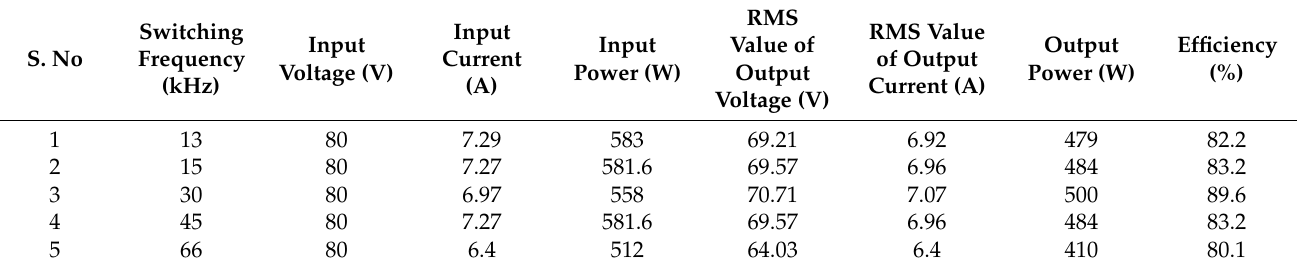
Figure 8. Variable frequency control: output voltage and current waveforms for ( a ) 15 kHz, ( b ) 30 kHz, and ( c ) 66 kHz switching frequency. ( d ) Switch voltage and current waveforms for 15 kHz switching frequency. ( e ) Temperature variation. ( f ) Heat rate for various switching frequencies. ( g ) FLIR thermal image for various switching frequencies at t = 5 min. Table 3. Efficiency of variable frequency